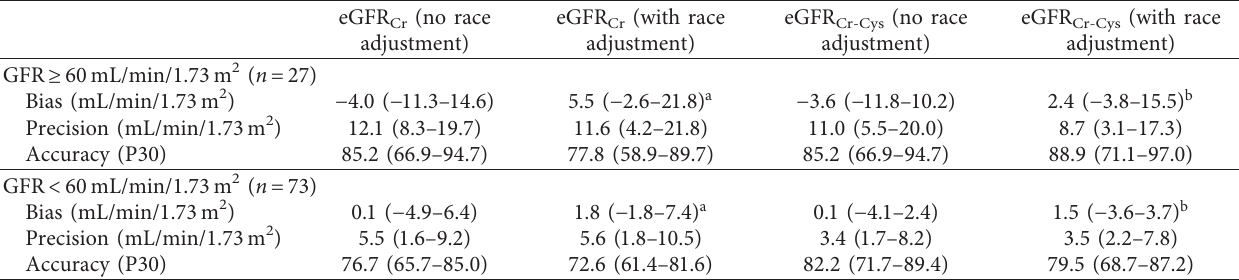
Table 6: Performance of the equations according to the range of measured GFR using the threshold of 60mL/min/1.73 m 2